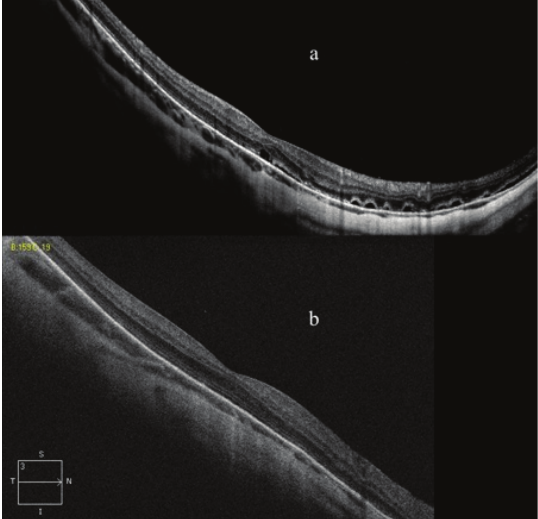
Figure 2. Case 5. OCT in a myopic patient with evidence of multiple areas of serous detachment of the neuroepithelium (a). Six months after SML photostimulation there are no detectable areas of detachment